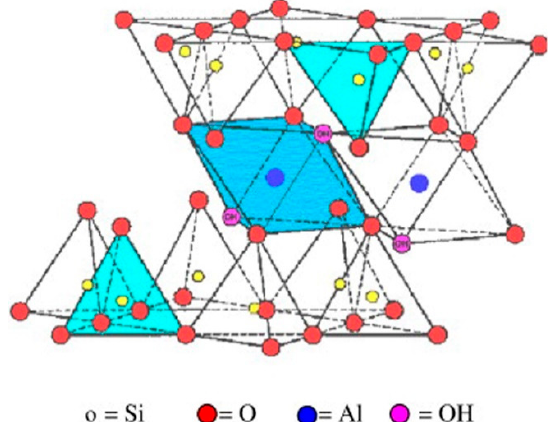
Figure 1. Molecular structure of montmorillonite. Reprinted with permission from [16]. Copyright 2008 Elsevier.